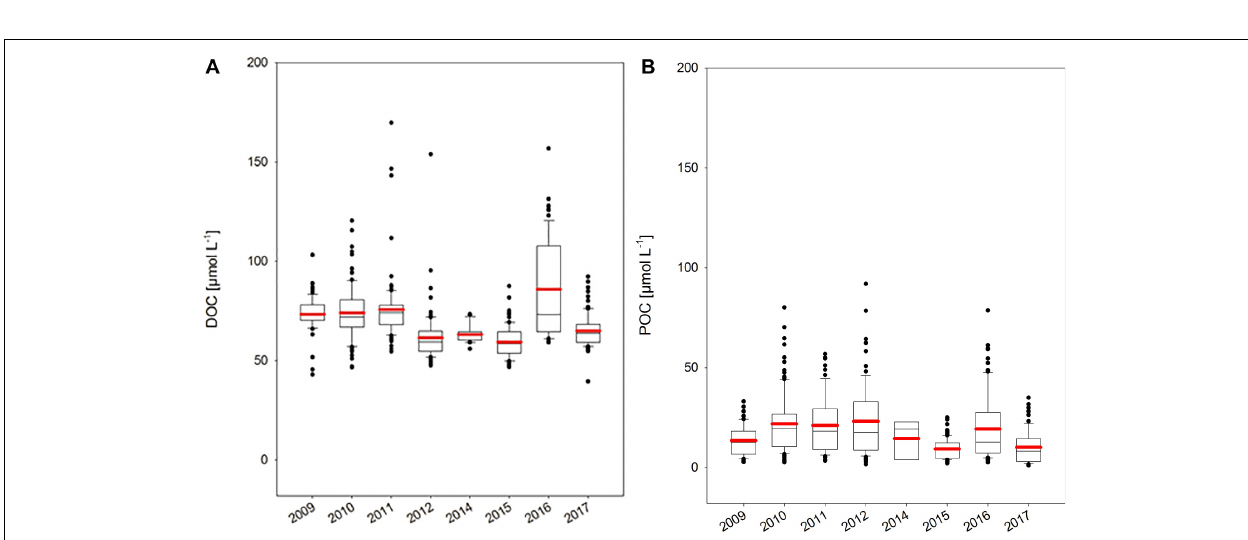
FIGURE 5 | (A,B) Deep profiles of DOC and POC concentrations observed in 2016 at the HAUSGARTEN stations S3 and HGIV.